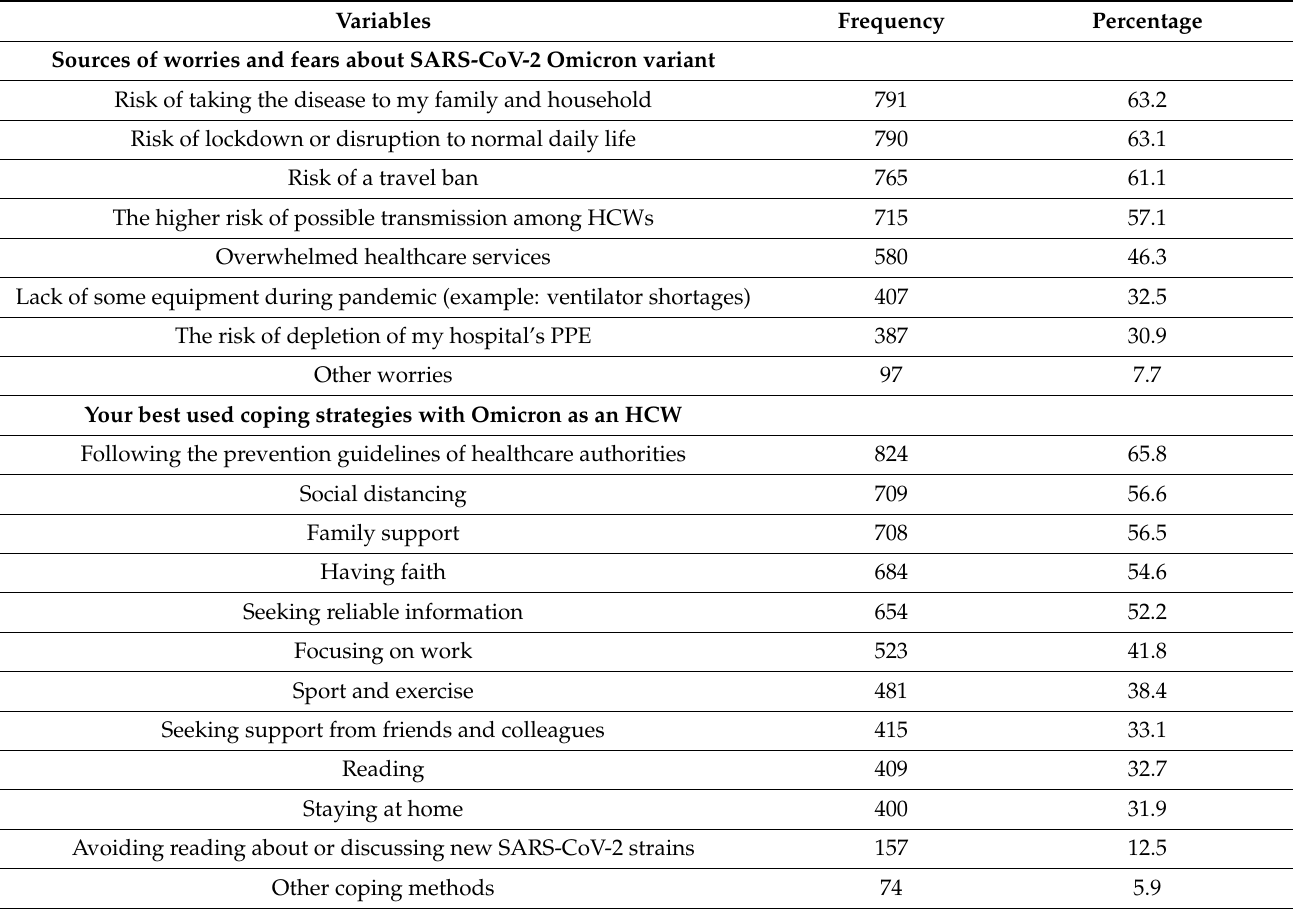
Table 4. Descriptive analysis of the HCW’s beliefs, attitudes, and practices concerning the Omicron